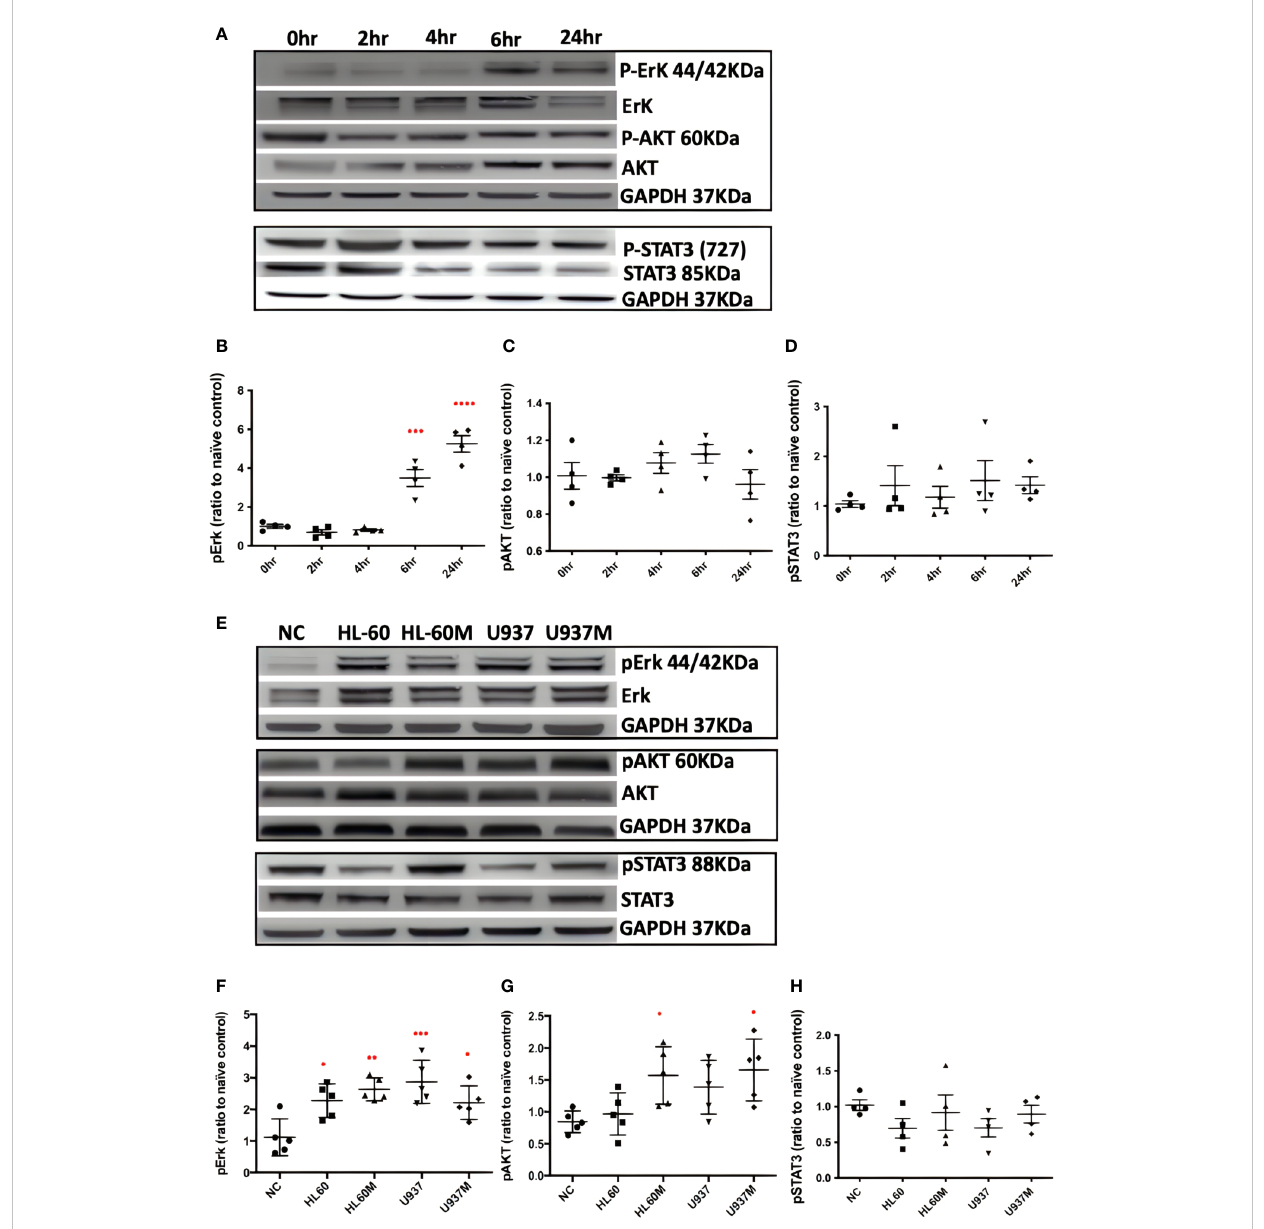
FIGURE 3 Both Bv8 and myeloid cells activated Erk signalling pathway in Caco-2 cells. (A) Caco-2 cells were treated with 1nM of Bv8 for various of time period. Western blot was performed and phosphorylation of Erk, AKT and STAT3 in Caco-2 cells were shown as densitometry. (B) Protein density of phosphorylated Erk (n=5) after Bv8 treatment. (C) Protein density of phosphorylated AKT (n=5) after Bv8 treatment. (D) Protein density of phosphorylated STAT3 (n=4) after Bv8 treatment. (E) In order to investigate if myeloid cell in fi ltration also induced activation of potential signalling pathways, HL60 cells, U937 Cells and cell medium extracted from both cell cultures were given to Caco-2 cells for 24 hours. Phosphorylation of Erk, AKT and STAT3 in Caco-2 cells were shown as densitometry. (F) Protein density of phosphorylated Erk (n=5) after co-culture treatment. (G) Protein density of phosphorylated AKT (n=5) after co-culture treatment. (H) Protein density of phosphorylated STAT3 (n=4) after co-culture treatment. Protein density was analyzed as ratio to naïve control. All statistic data was illustrated as mean ± SD. Student ’ s t test was used for statistical analysis. *p<0.05, **p<0.01, ***p<0.001, ****p<0.0001. NC, naïve control; HL60, co-cultured with HL60 cells; HL60M, co-cultured with HL60 medium; U937, co-cultured with U937 cells; U937M, co-cultured with U937M. n refers to the number of independent